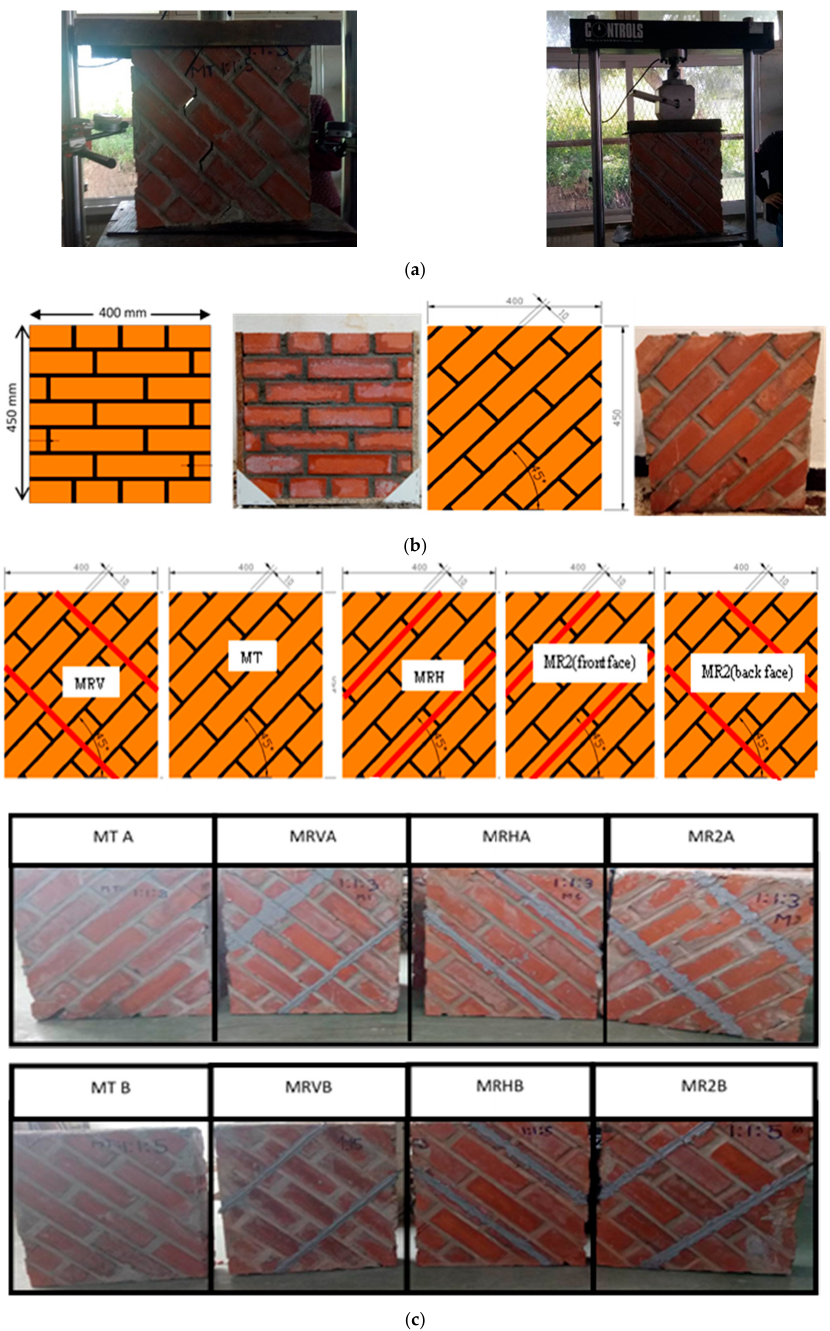
Figure 2. ( a ) Test setup; ( b ) configuration of unreinforced masonry walls ( θ = 90°, θ = 45°); ( c ) configuration of reinforced masonry walls ( θ = 45°).